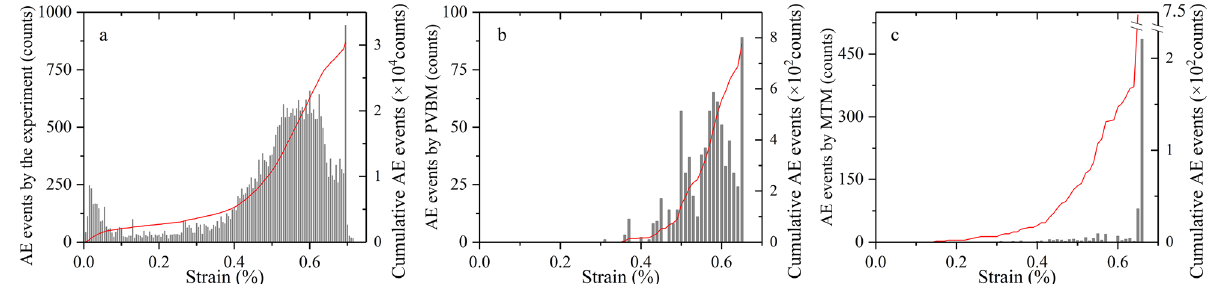
Figure 12. Comparison of AE events by the ( a ) experiment; ( b ) PVBM; and ( c )